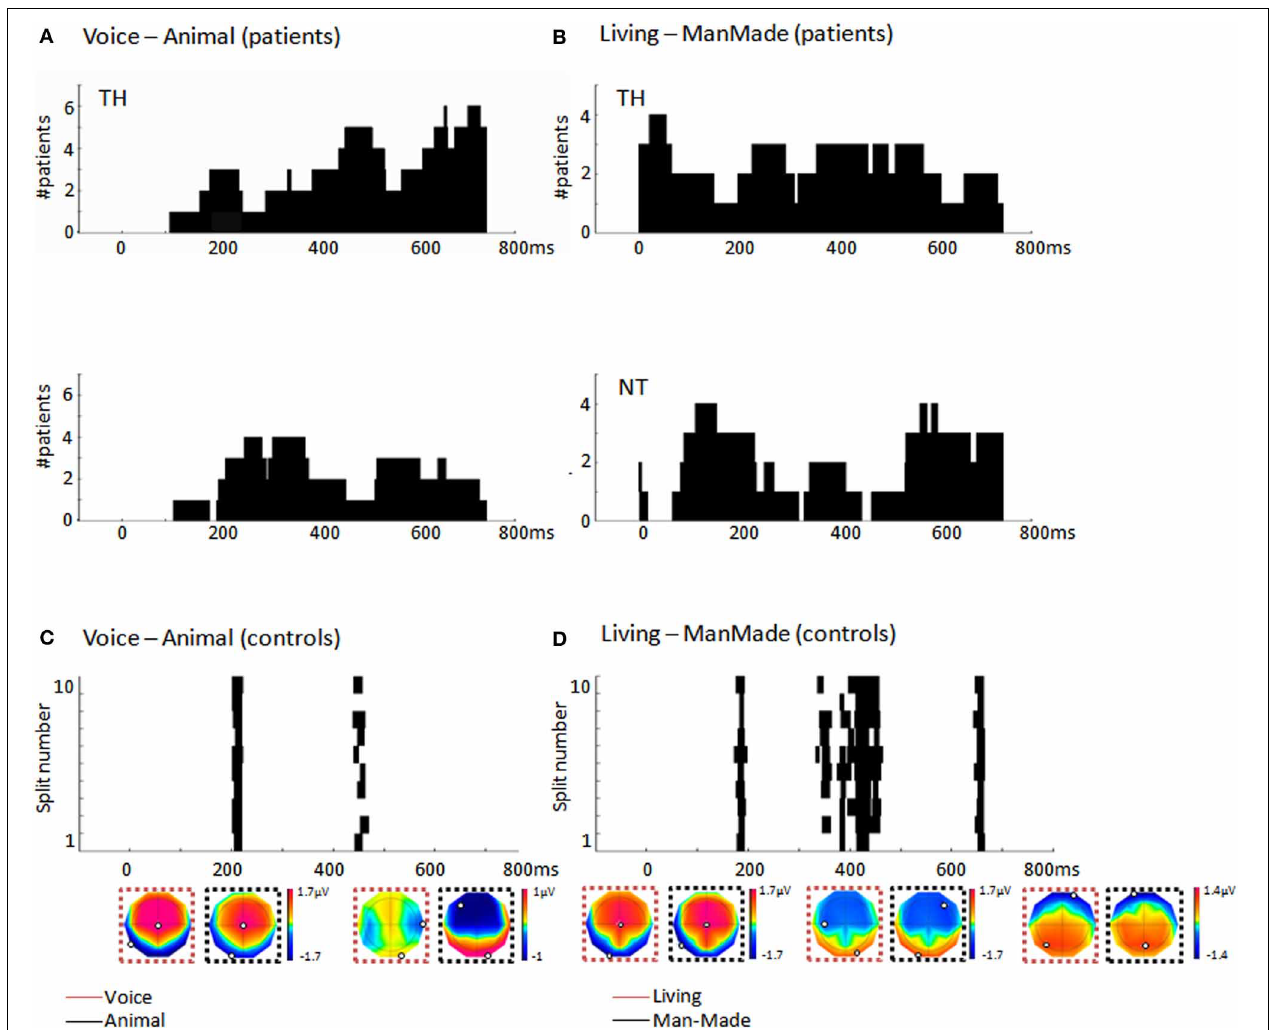
FIGURE 3 | (A) Histograms (40ms bins) of the time-periods of differential activity (H, cf. section “Multivariate EEG decoding”) in response to different vocalization types as computed by the single-trial decoding analysis across the significant patients. Top panel: During TH for the human/animal comparison, the most consistent period was at ∼ 450ms post-stimulus onset, observed in five out of the seven significant patients. Bottom panel: During NT half of the patients showed earlier discriminative periods at ∼ 300ms (B) Histograms (40ms bins) of the time-periods of differential activity, H, in response to living and man-made sounds as computed by the single-trial decoding analysis across the significant patients. Top panel: During TH, the living/manmade comparisons provided a consistent period of differential activity starting already at ∼ 50ms post-stimulus onset in four out of the five patients; Bottom panel: During NT four patients out of six had a consistent period of differential activity between living and man-made sounds